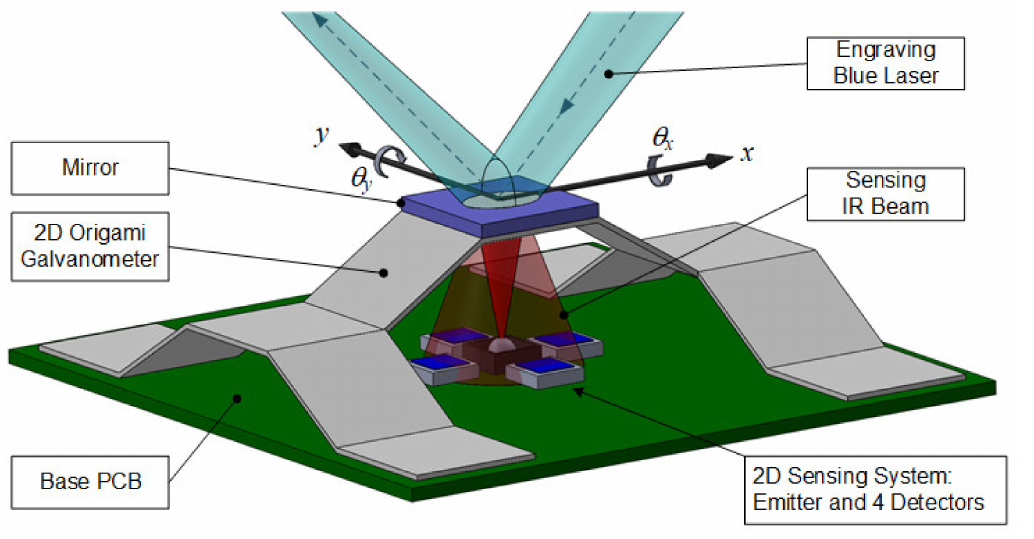
Figure 13. The concept of the 2D origami galvanometer with an optical sensing